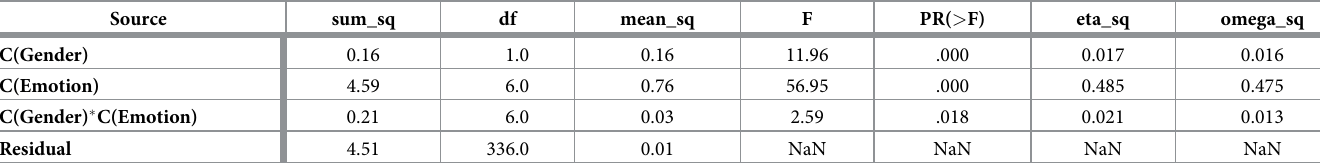
Table 14. Descriptive table for two-way ANOVA for Phase 1(for rater gender).